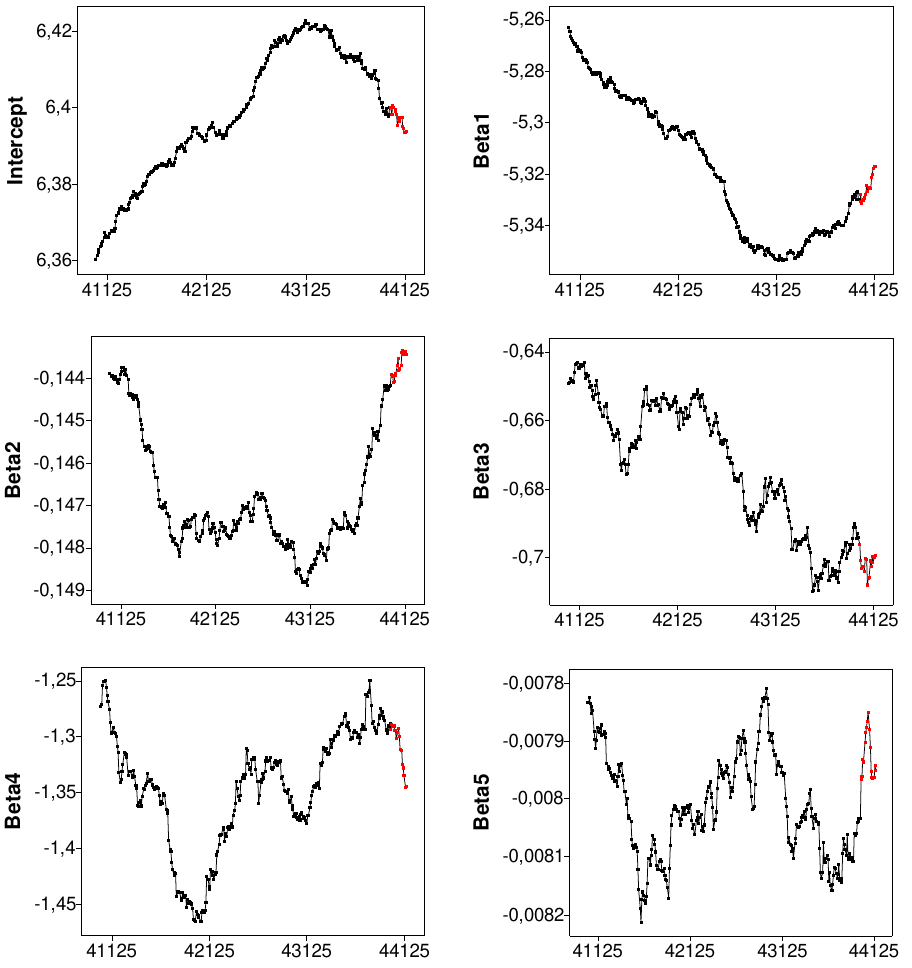
Figure 9. SAS batch analysis of balance sheet data: monitoring of estimated beta coefficients on transformed data, starting from 41,000 units with the part of the trajectory corresponding to the 161 detected outliers, highlighted in red (in the online .pdf version).